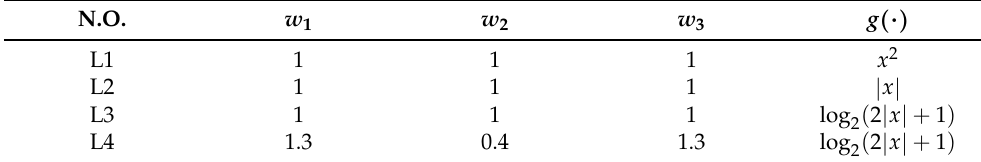
Table 2. The settings of the loss function.